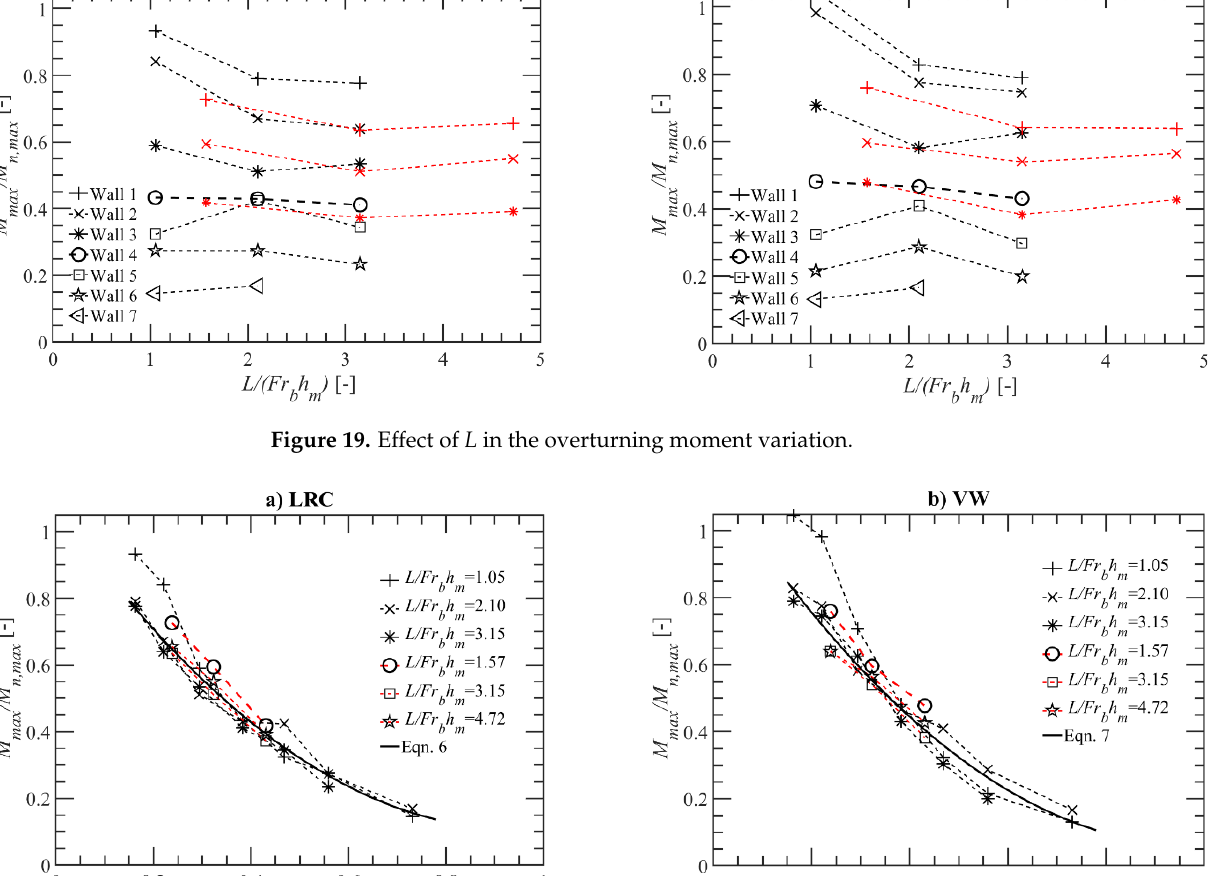
Figure 18. Comparison of time of maximum force and time of maximum moment in the presence of a mitigation wall. (Black squares represents the LRC, and red circles represents the VW). τ = ( t − t im ) .